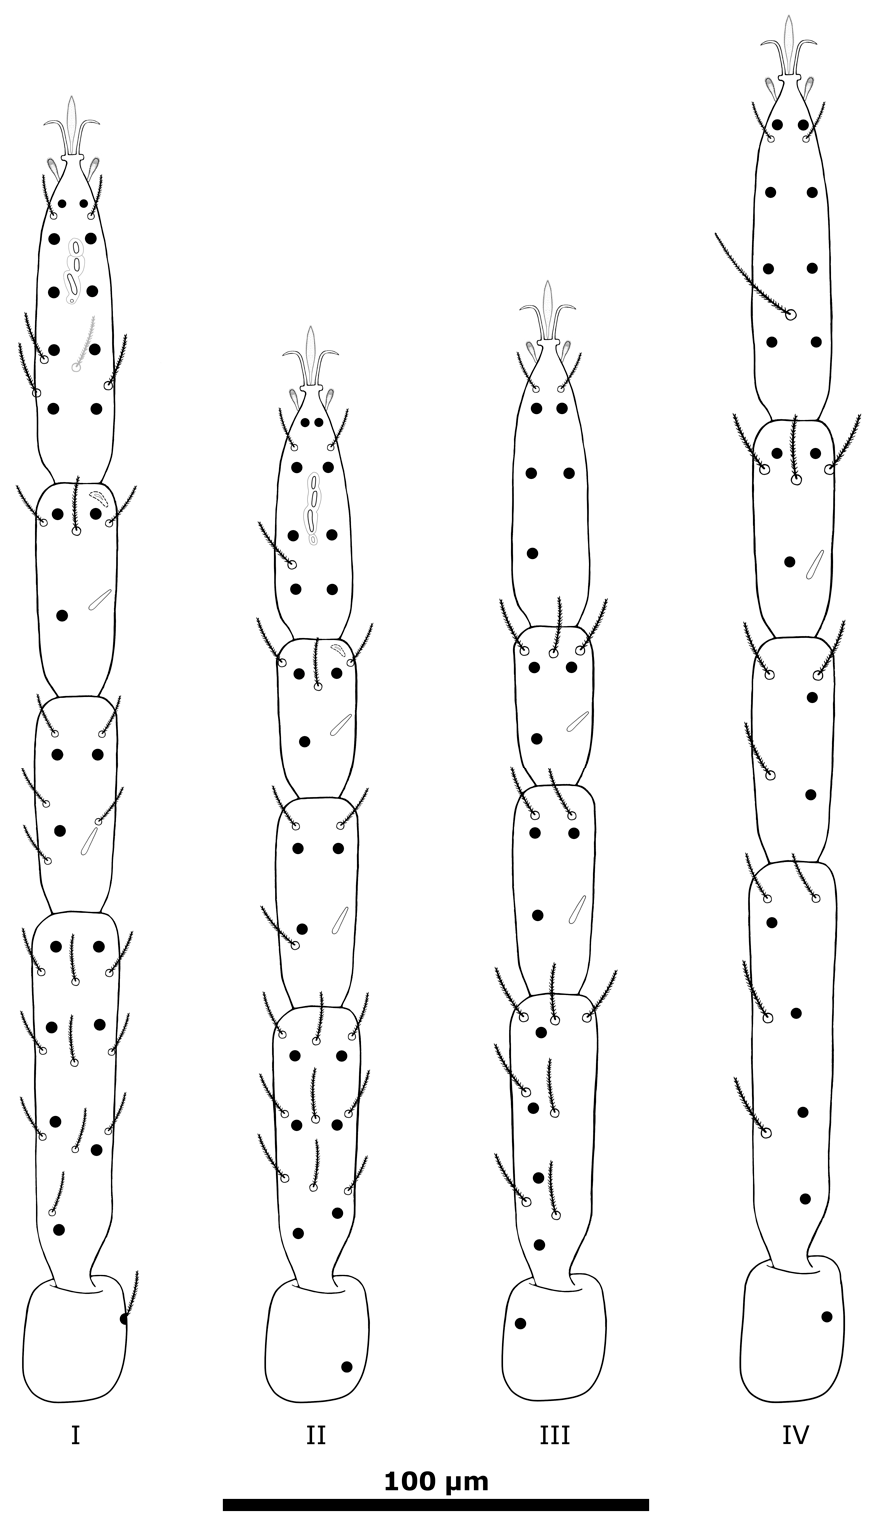
Figure 3. S. ineffabilis sp. nov. Chaetotaxy of legs of Inexpressible Island specimens; black dots represent the setae on the ventral side; light grey indicates setae that are sometimes missing; rhagidial organs visible on tarsi I and II and subtended by small nude round setae; outlines after the drawings of Pittard [2] arranged with proportions and details of S. ineffabilis individuals.